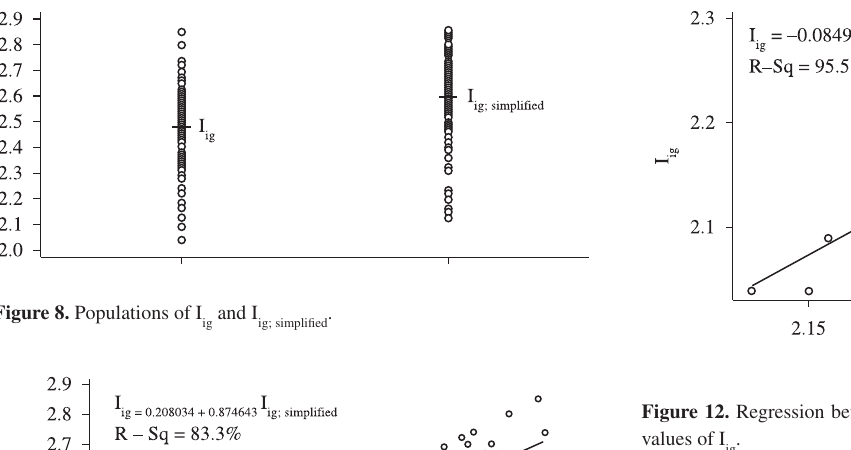
and I for the cities of the least ig ig; simplified